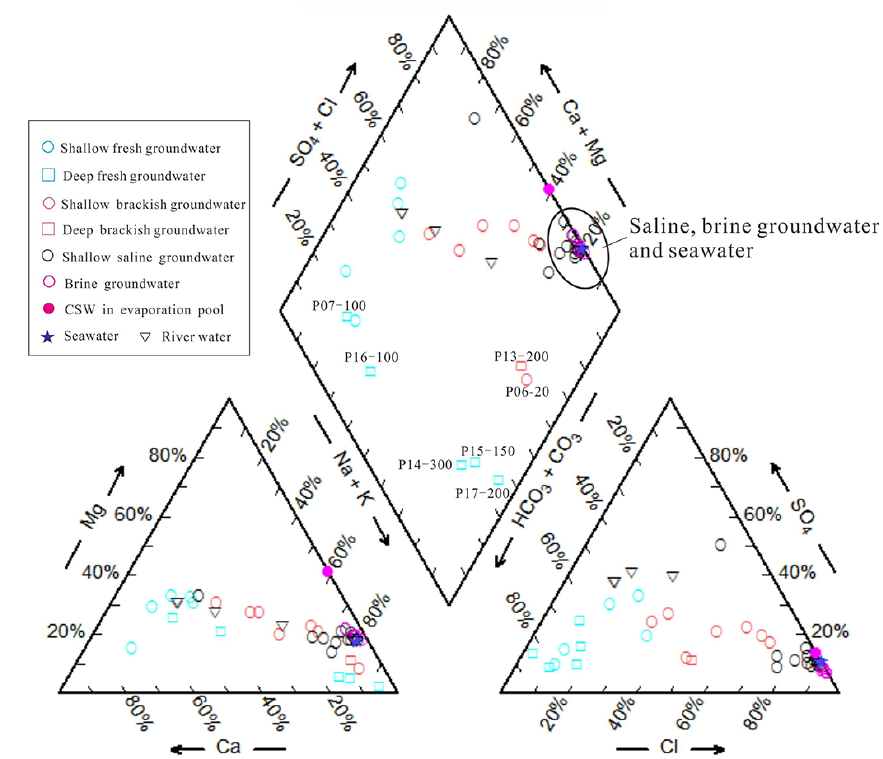
Figure 3. Piper diagram of the various water